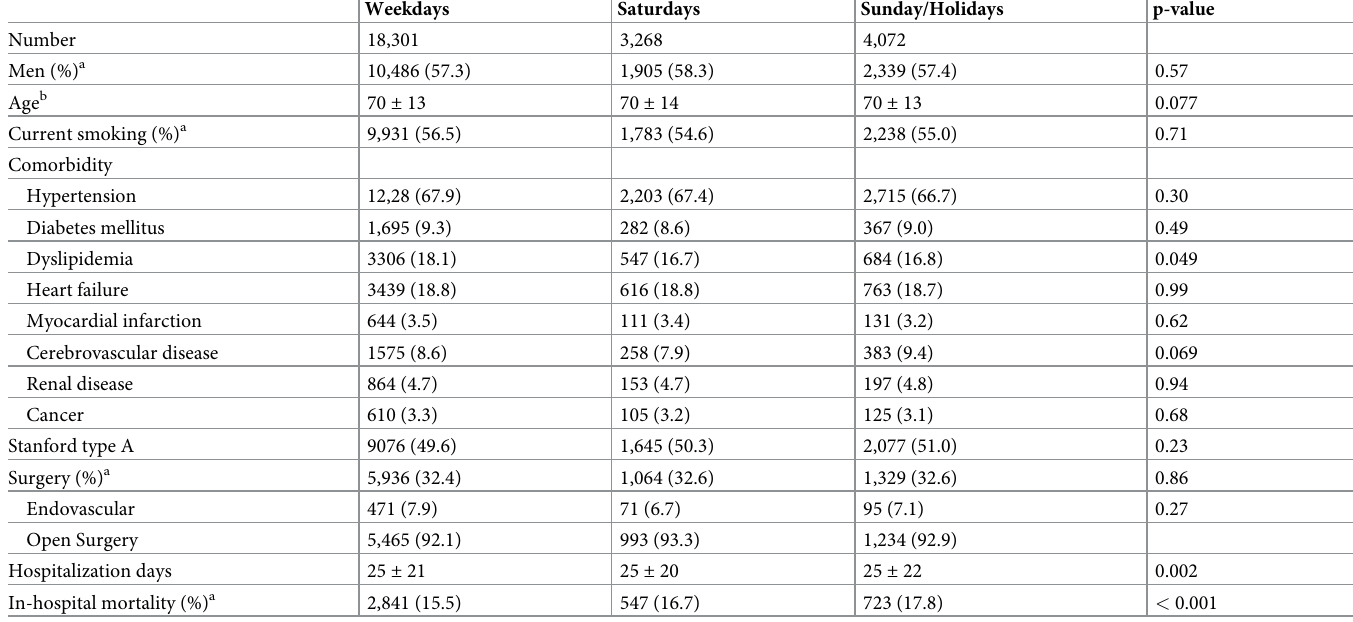
Table 1. Characteristics of patients with acute aortic dissection according to admission day.